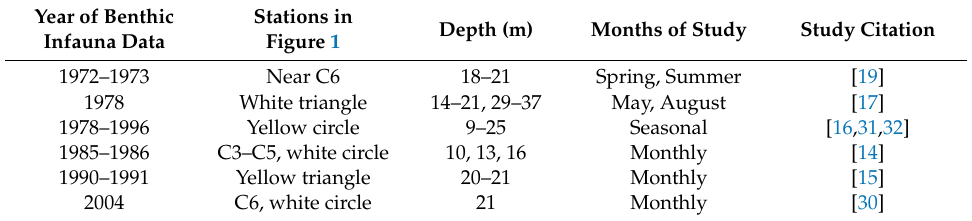
Table 1. Selected studies of benthic macroinfauna in the Louisiana bight and adjacent areas where summer bottom-water hypoxia is frequently present (Figure